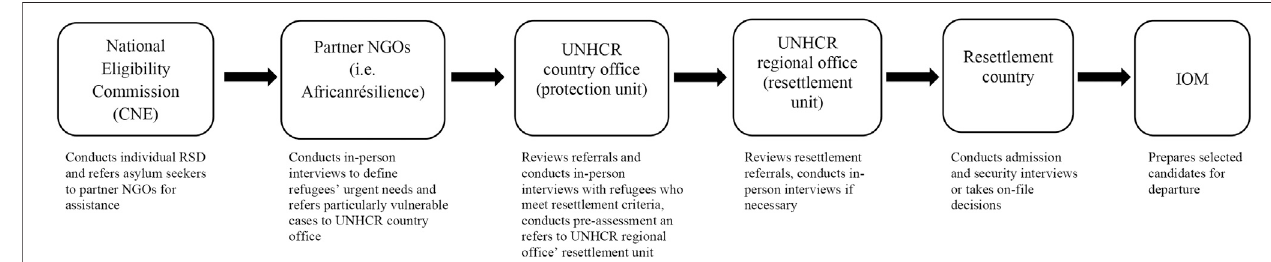
FIGURE 1 | Regular process of refugee selection for resettlement from country B, based on fi eldwork insights.